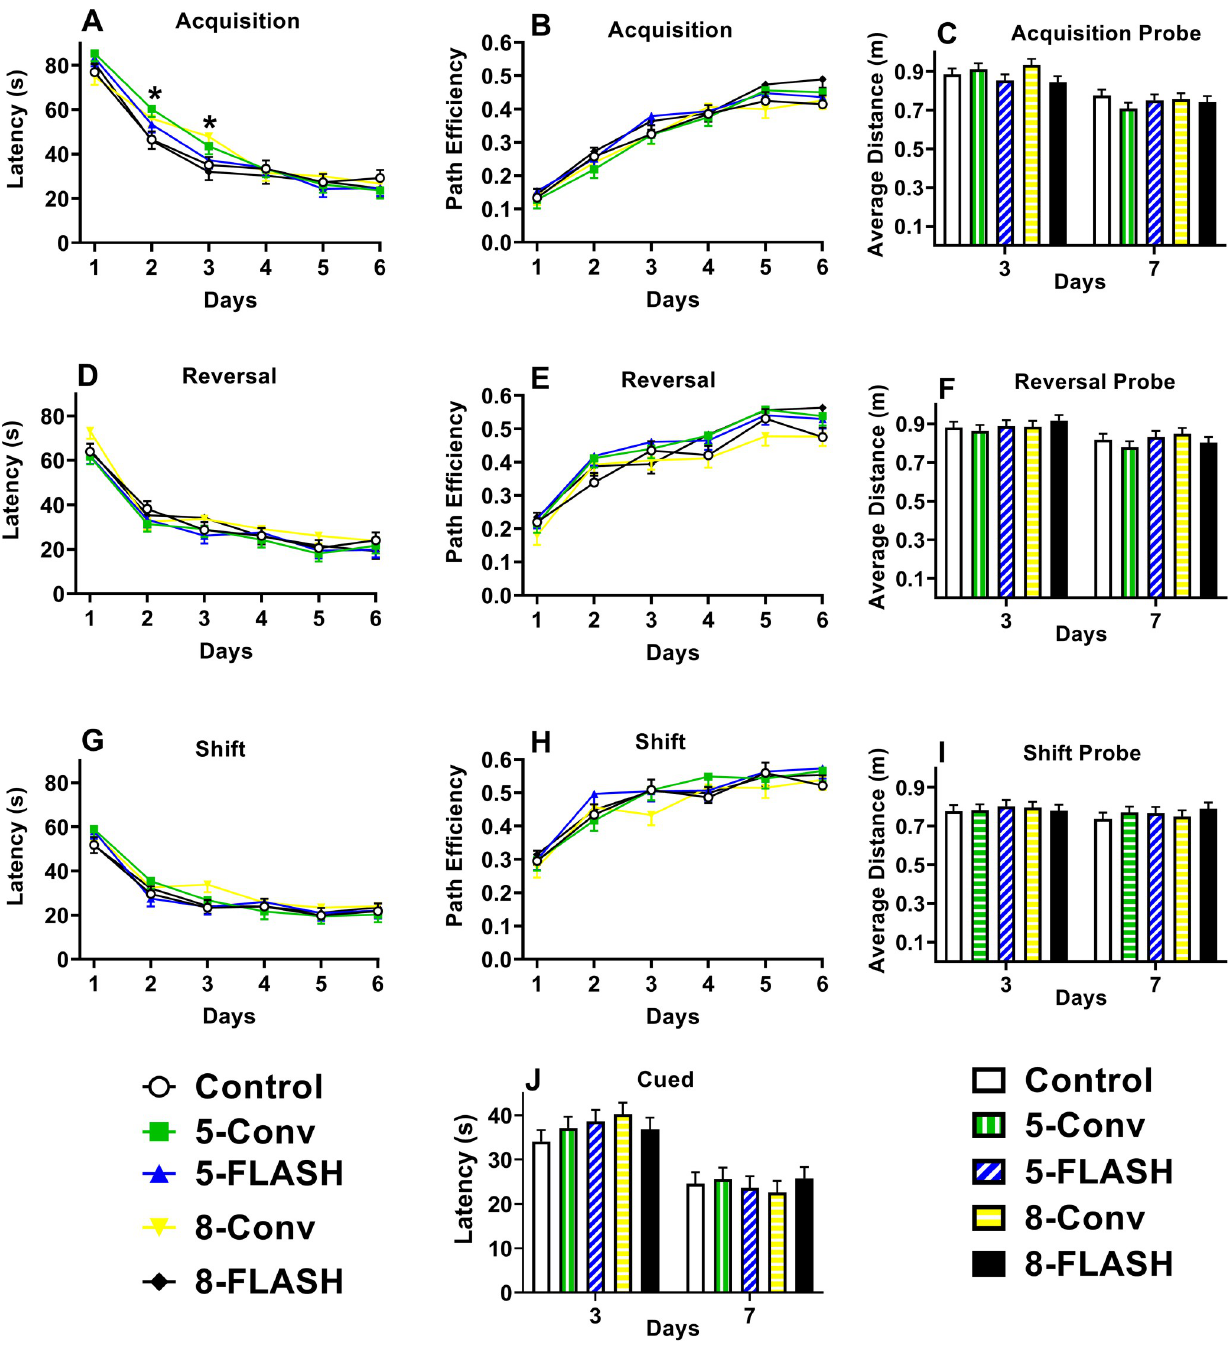
Fig 7. The Morris water maze latency [s (mean ± SEM)], path efficiency (mean ± SEM), and average distance from the platform on probe trials [m (mean ± SEM)] for the acquisition (A, B, C), reversal (D, E, F), and shift (G, H, I) phases and latency [s (mean ± SEM)] during the cued (J) phase of proton irradiated and control rats. There were no overall differences between the irradiated groups and controls on any measure in the Morris water maze. There was a significant interaction of exposure × day for acquisition latency where the 5-Conv and 8-Conv groups took longer to locate the platform on days 2 and 3 compared with the controls, � p < 0.05. No other interactions involving exposure were found. N = 19/sex/exposure except control male and 5-FLASH male =